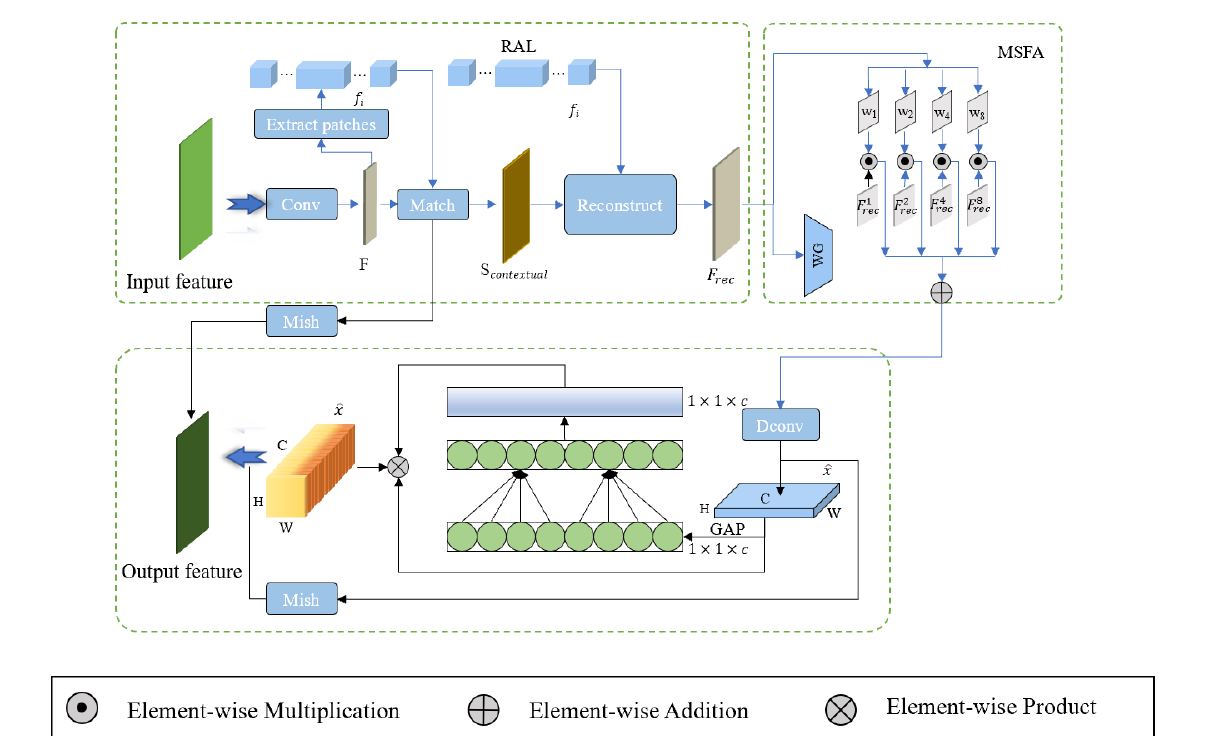
Figure 4. Multiscale feature fusion module for dual-attention